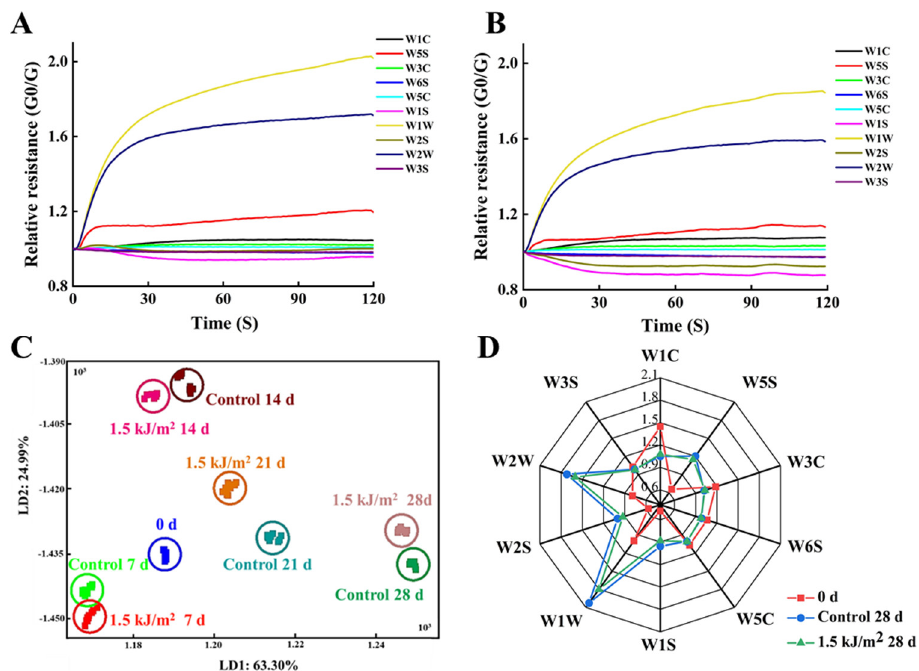
Figure 4. E-nose sensor intensity for volatile compounds in control pepino fruit ( A ) and 1.5 kJ/m 2 UV-C treated pepino fruit ( B ) harvested for day 28. ( C ) Linear discriminant analysis of E-nose data for control pepino fruit and 1.5 kJ/m 2 UV-C treated pepino fruit harvested at different time. ( D ) Radar fingerprint chart of volatile compounds in control pepino fruit and 1.5 kJ/m 2 UV-C treated pepino fruit harvested for 28 d. Pulp tissues were used to obtain the E-nose profiles.